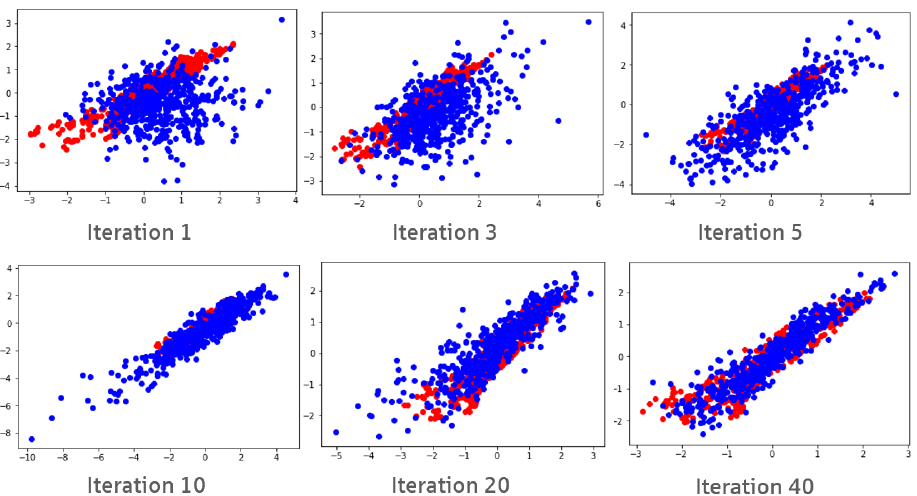
Figure 3. Scatterplots of results of a GAN for a two-dimensional data distribution at different training iterations: red = empirical data; blue = generated